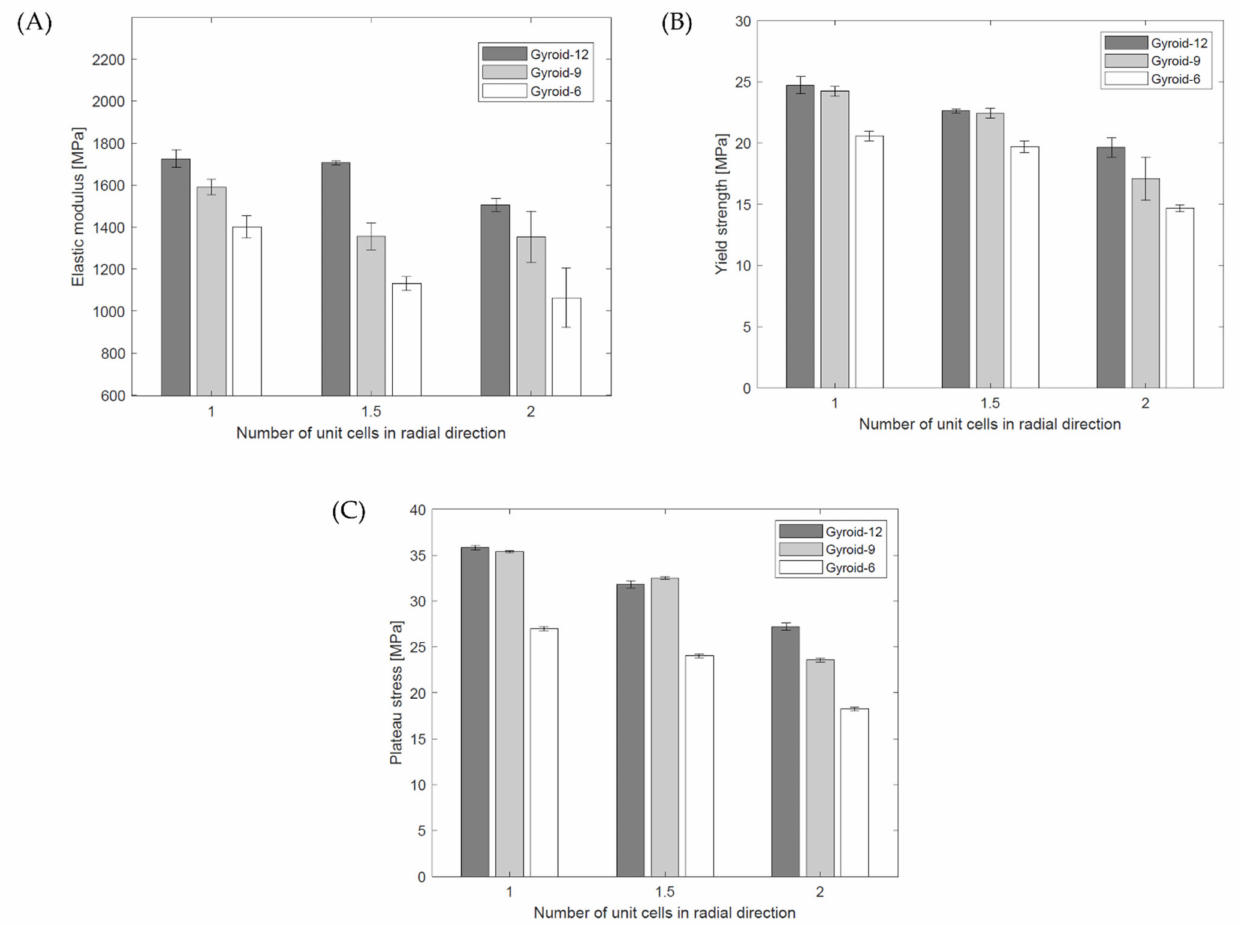
Figure 10. Mechanical properties of tested cylindrical mapped gyroid structures: ( A ) elastic modulus, ( B ) yield strength, ( C ) plateau